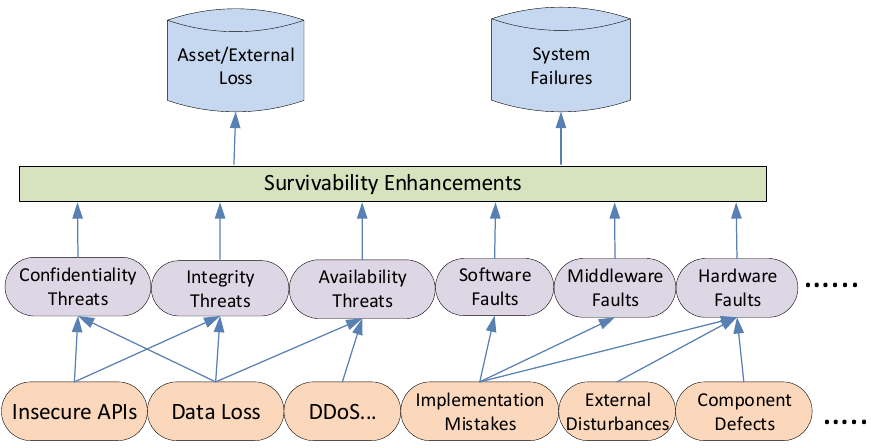
Figure 1. Survivability architecture.